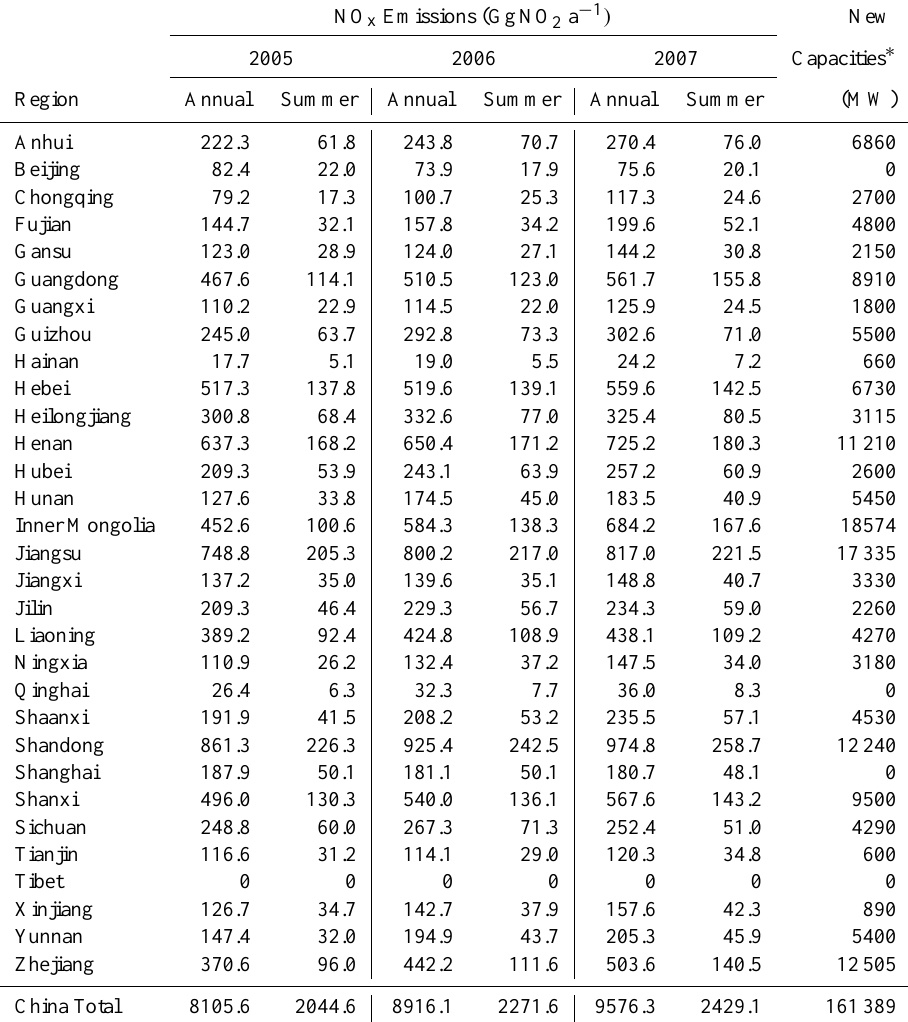
Table 2. Annual and summer (June to August) NO x emissions from coal-fired power plants in 2005–2007 in mainland